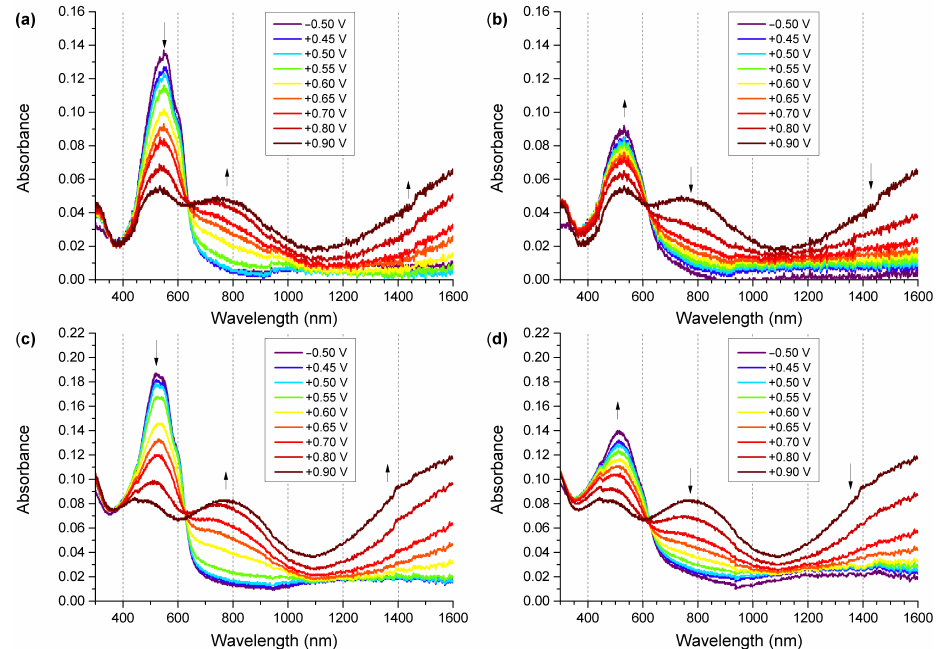
Figure 3. UV-Vis-NIR spectra of polymers during oxidation and reduction process: ( a ) SilPEG oxidation; ( b ) SilPEG reduction; ( c ) DodecSIL oxidation; ( d ) DodecSIL